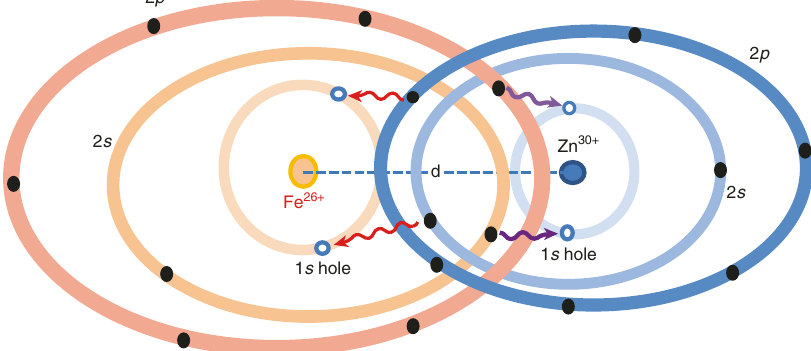
Fig. 1 The schematic diagram of interspecies radiative transition in superdense plasmas. Due to the high compression of superdense plasmas, ions of different species can get so close to each other that their atomic states may become overlapping. In such a superdense environment, photon-pumping or collision-induced 1 s -core holes can be fi lled by 2 p electrons from other species, giving rise to inter-atomic K α